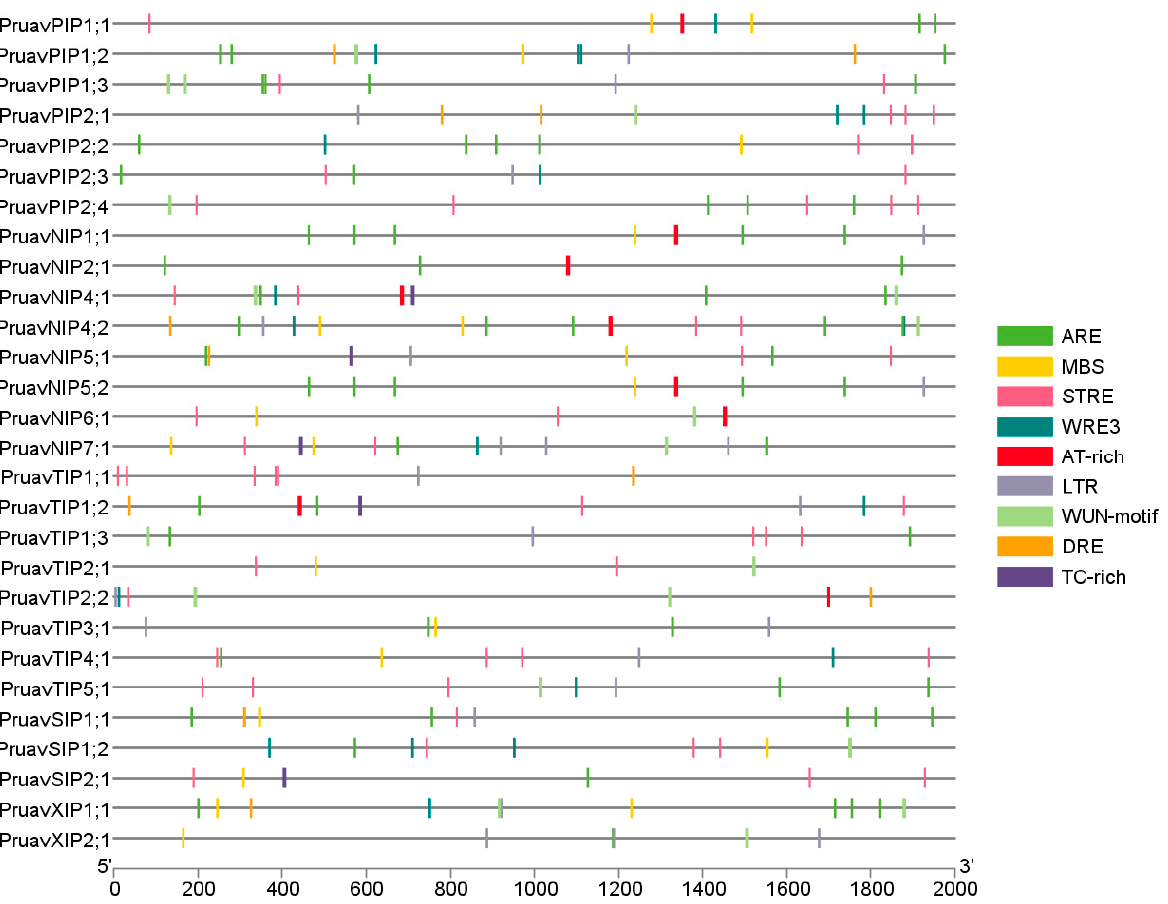
Figure 3. Analysis of cis-acting regulatory elements of the aquaporin gene family of P. avium . A total of 2000 bp promoter sequences of 28 aquaporin genes were analyzed using the PlantCARE database. Different color boxes represent the cis-acting regulatory elements for stress response.